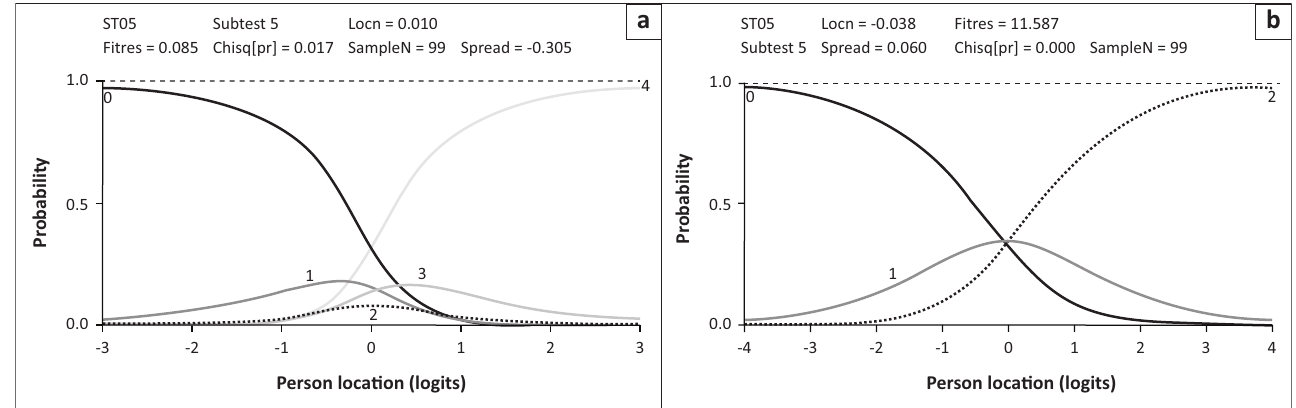
FIGURE 9: (a) Subtest 5 (question 11) – original score category probability curve, (b) Subtest 5 (question 11) – re-scored category probability curve.